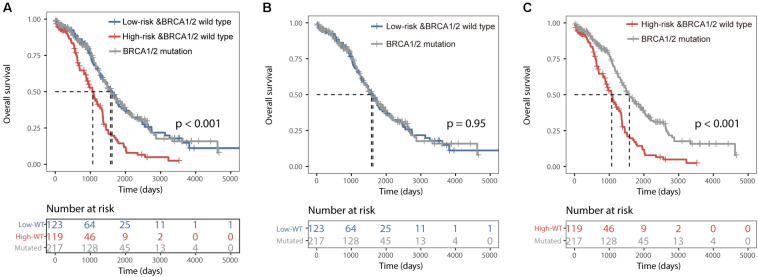
Prognostic differences among three group patients. (A) Kaplan–Meier survival curves of overall survival among BRCA1/2 mutation group, the BRCALncSig-related high-risk wild-type group and the BRCALncSig-related low-risk wild-type group. (B) Kaplan–Meier survival curves of overall survival between BRCA1/2 mutation group and BRCALncSig-related low-risk wild-type group. (C) Kaplan–Meier survival curves of overall survival between the BRCA1/2 mutation group and the BRCALncSig-related high-risk wild-type group.